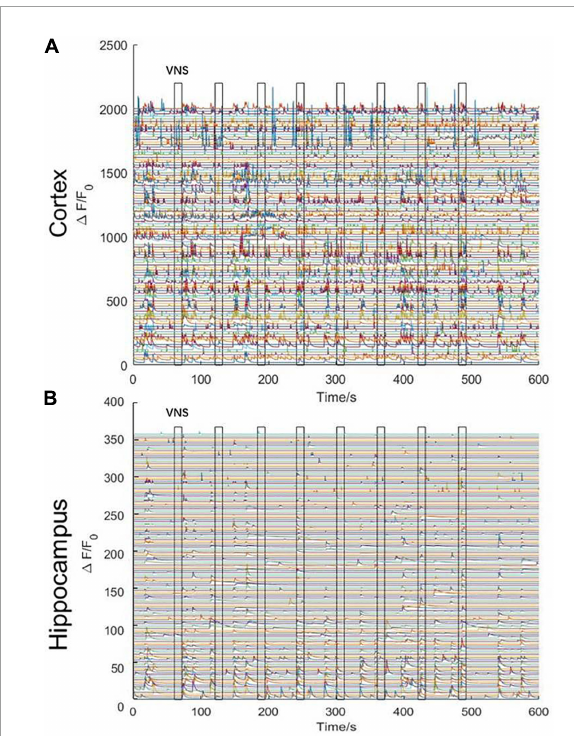
FIGURE3 Curve diagram of calcium signaling of neurons in the cerebral cortex and hippocampal CA1 in awake states during VNS. (A) Curve diagram of calcium signaling of neurons in the cerebral cortex during VNS. (B) Curve diagram of calcium signaling of neurons in the hippocampal CA1 during VNS. Narrow gray rectangles indicate time of each VNS application (lasting 10 s). Y-axis indicates neuron numbers.